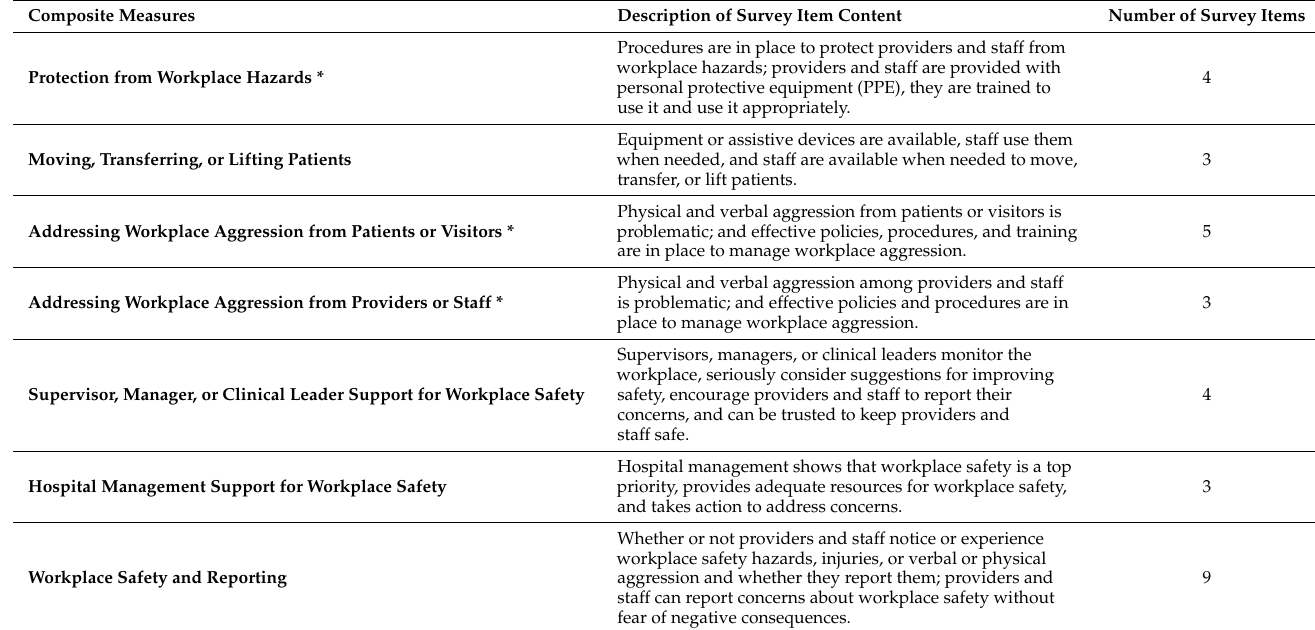
Table 1. Workplace safety supplemental items seven a priori composite